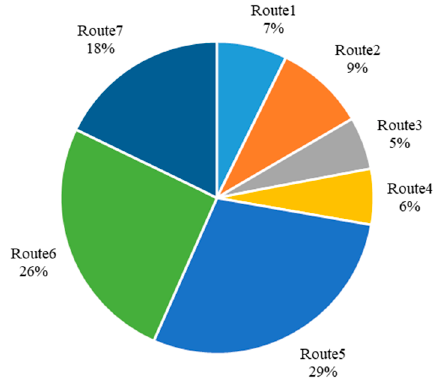
Figure 9. Shuttle service ridership distribution.